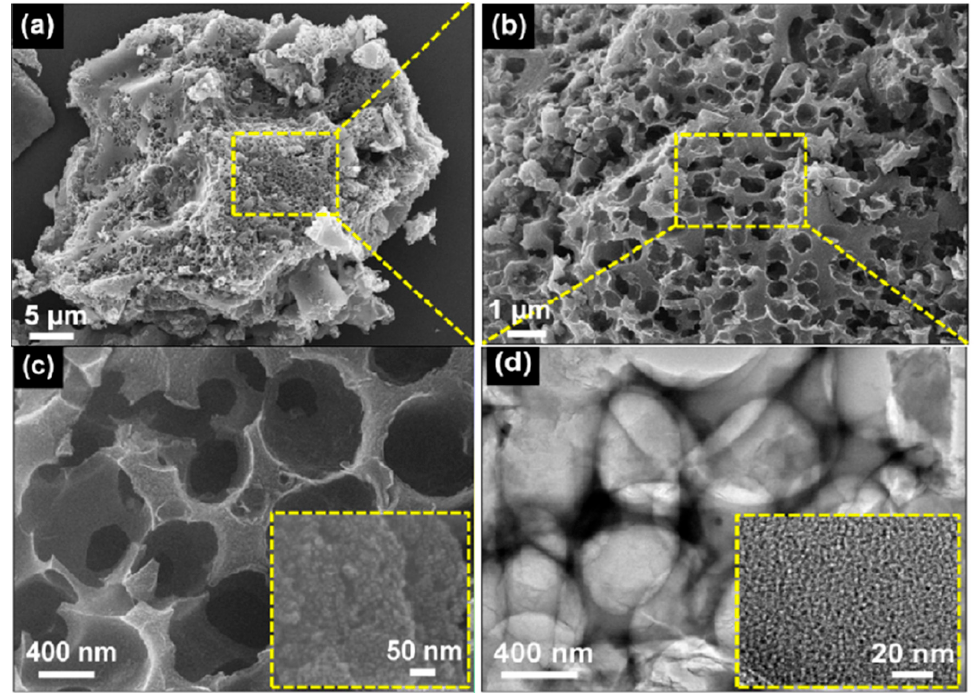
Figure 11. Schematic diagram showing the importance of porous carbon nanostructures as high- efficiency CEs in